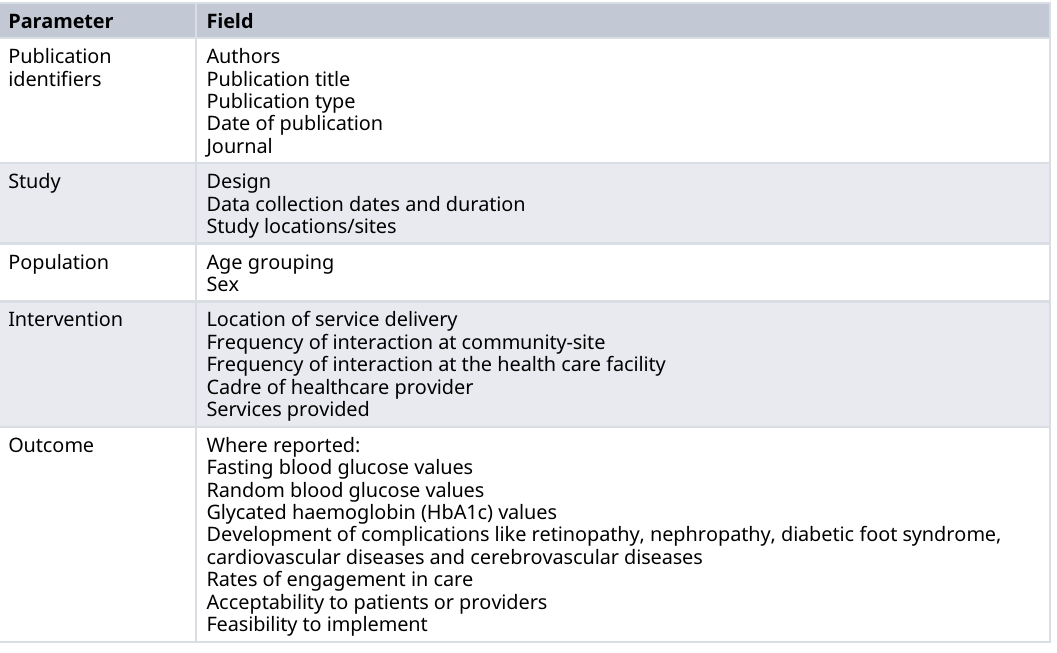
Figshare: Community-based models of care for management of type 2 diabetes mellitus among non-pregnant adults in sub-Saharan Africa: a scoping review search strategy, https://doi.org/10.6084/m9.figshare.14610090.v3. 24 This project contains details of the search string in Embase.